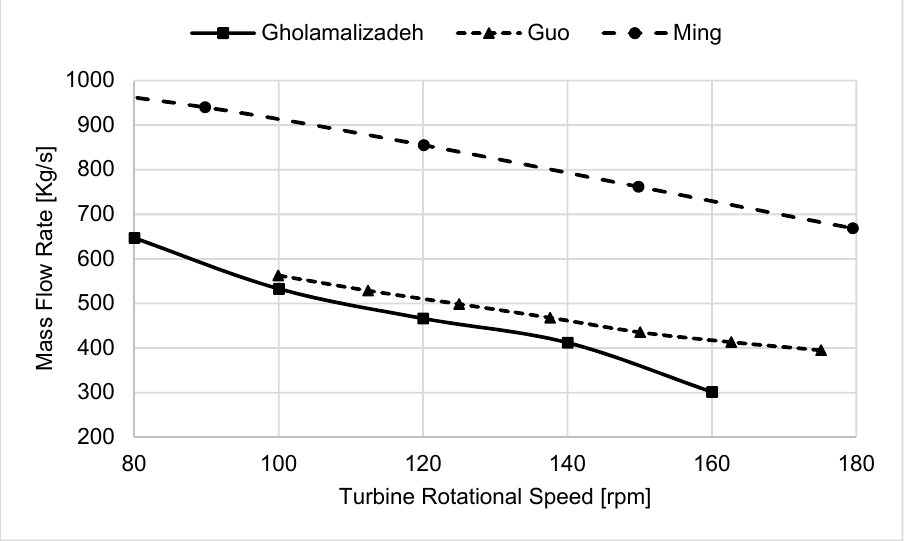
Figure 3. Mass flow rate at different turbine rotational speeds.